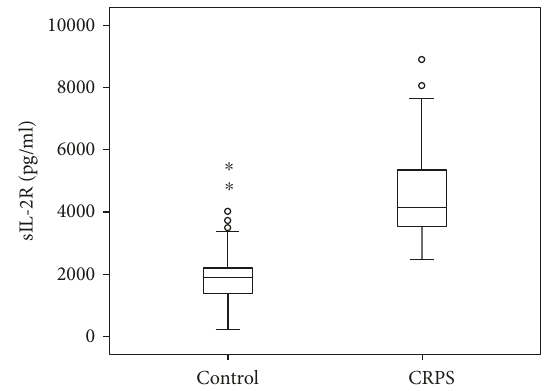
Figure 1: Boxplot of the sIL-2R level by the experimental group. ∗ Healthy controls with sIL-2R levels that are more than three times the IQ-range.